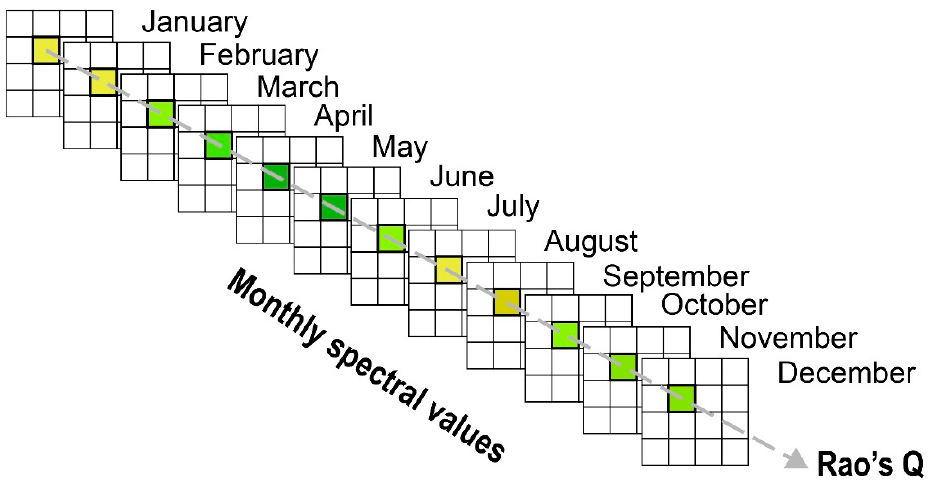
Figure 3. Schematic representation of temporal Rao’s Q diversity calculation implemented on year stacks of spectral indices MSAVI2, NDWI2 and BI2 to summarize the seasonal behavior of vegetation biomass, water and bare soil surfaces on coastal dunes.